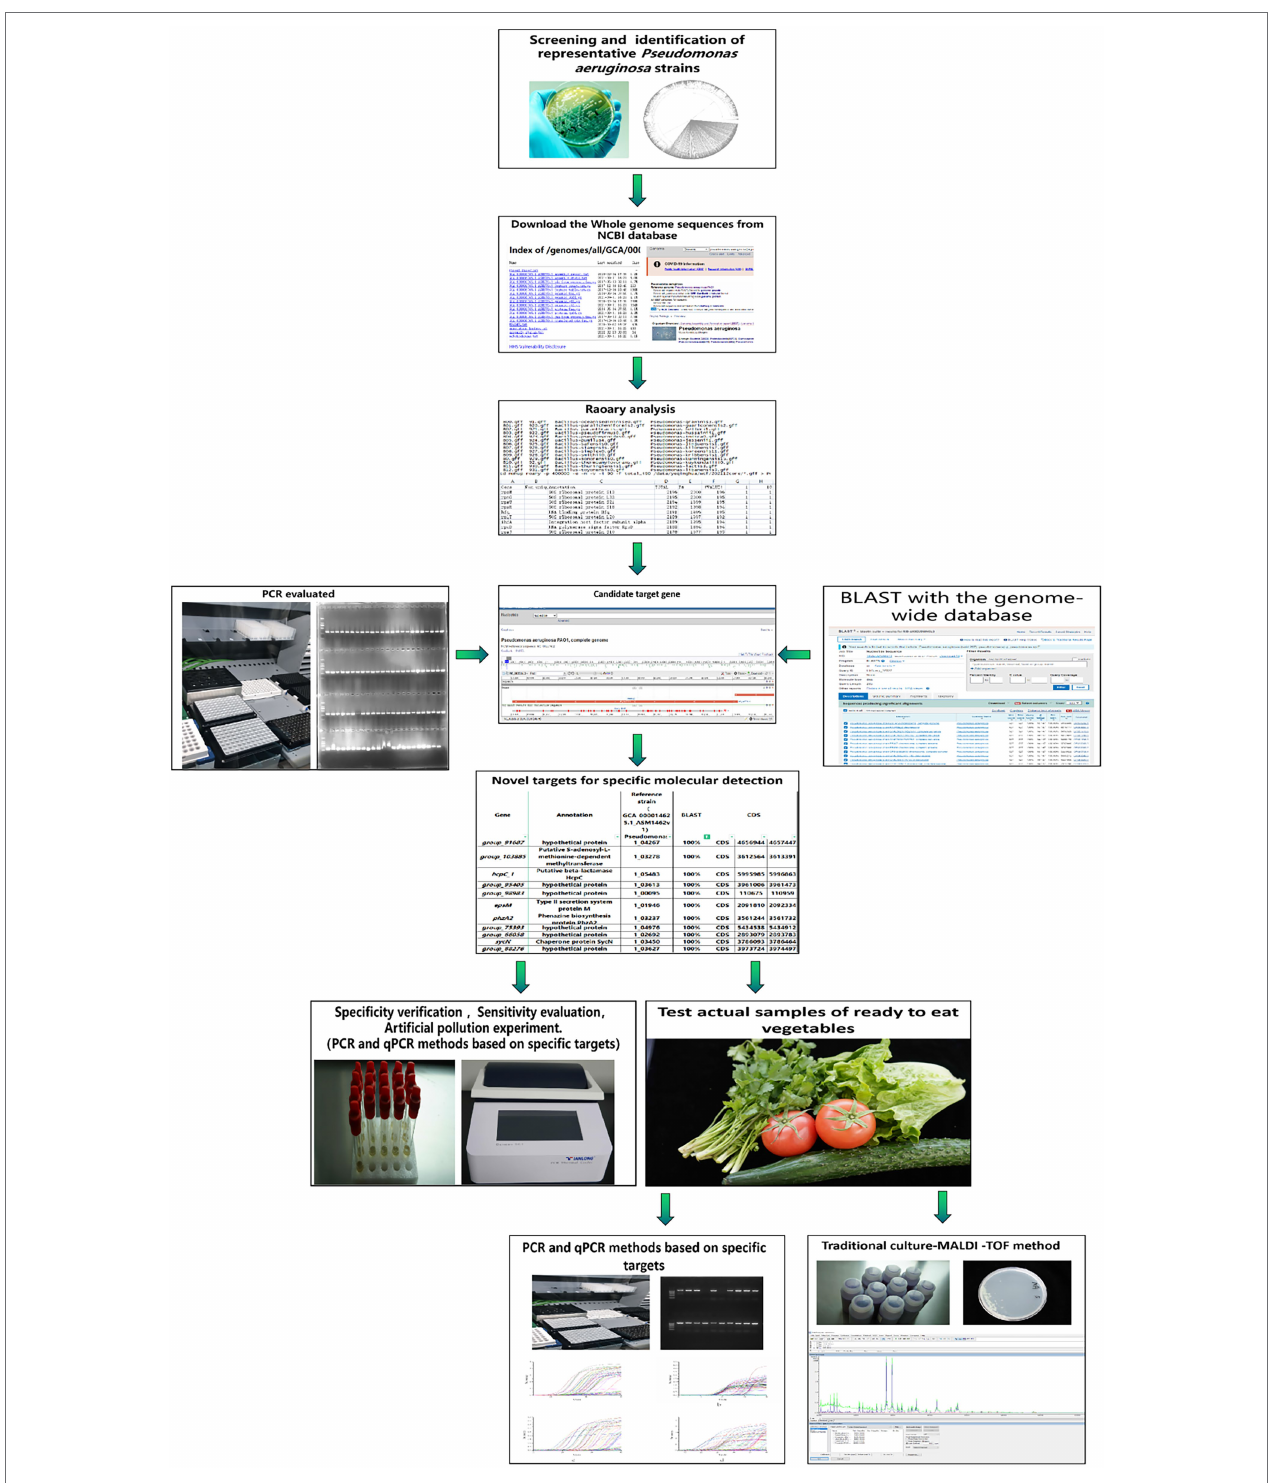
FIGURE 1 | The flowchart of the experimental method involved in this